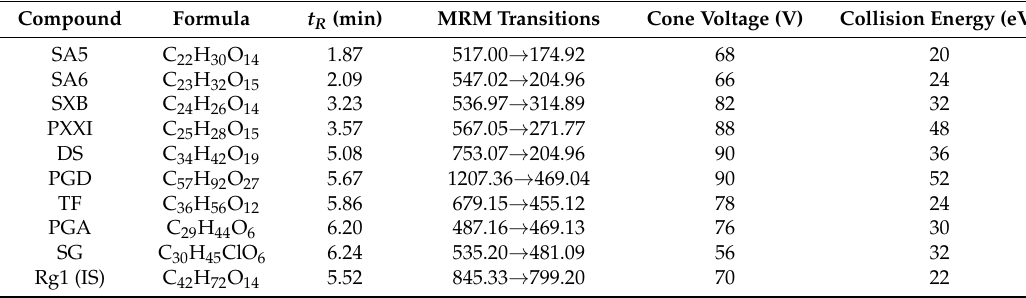
Table 1. The detecting parameters of compounds in MRM mode for LC-MS/MS